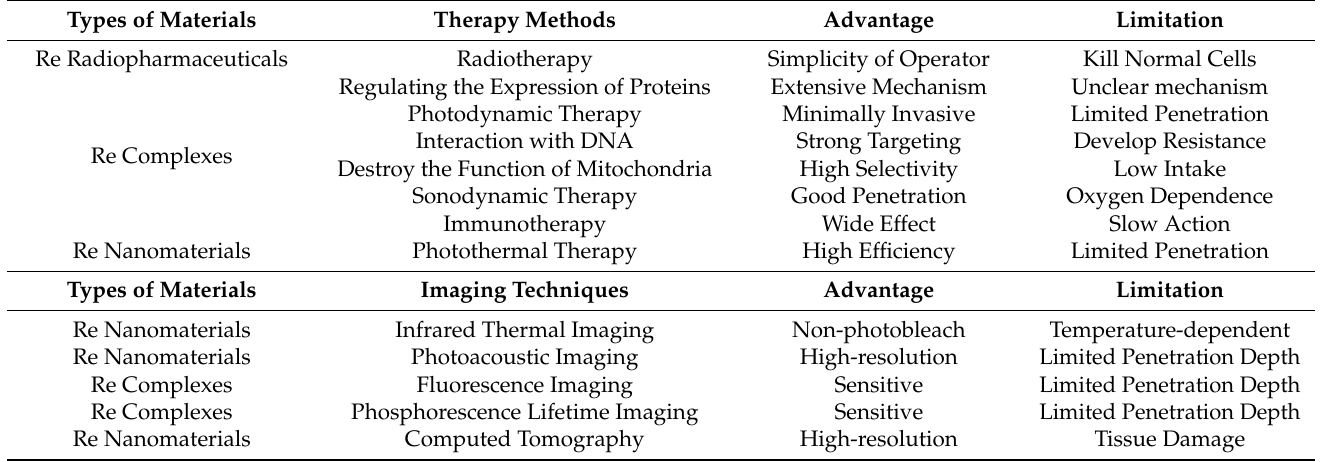
Table 3. The cancer diagnosis and treatment techniques in this